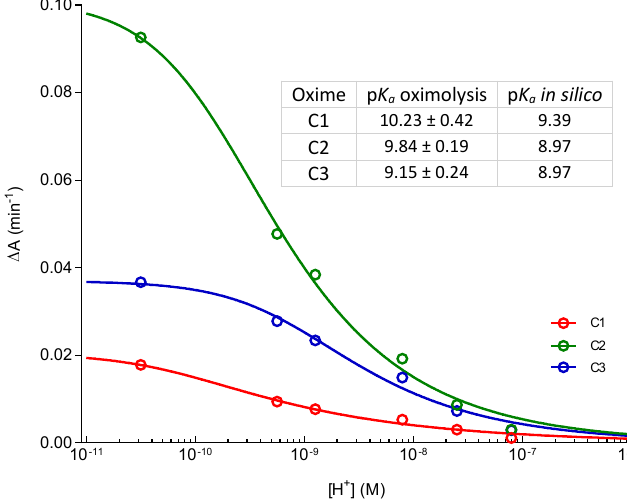
Figure 3. [H + ]-dependence of oximolysis rate for C1, C2 and C3 oximes (0.1 mM) and their in vitro and in silico determined p K a values. Acid dissociation constant ( K a ) of the oxime group was determined by measuring the degradation of substrate acetylthiocholine (1 mM) by 100 µM oxime at 412 nm and in pH range 4.4–11.3 and was calculated using the Equation (1) (see Section 3.4).